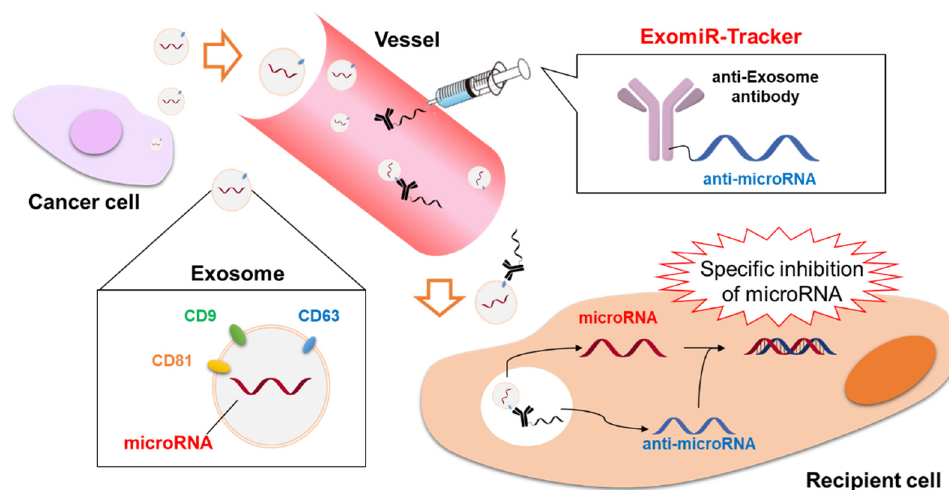
Figure 3. Schematic representation of the concept of “ExomiR-Tracker” [43].